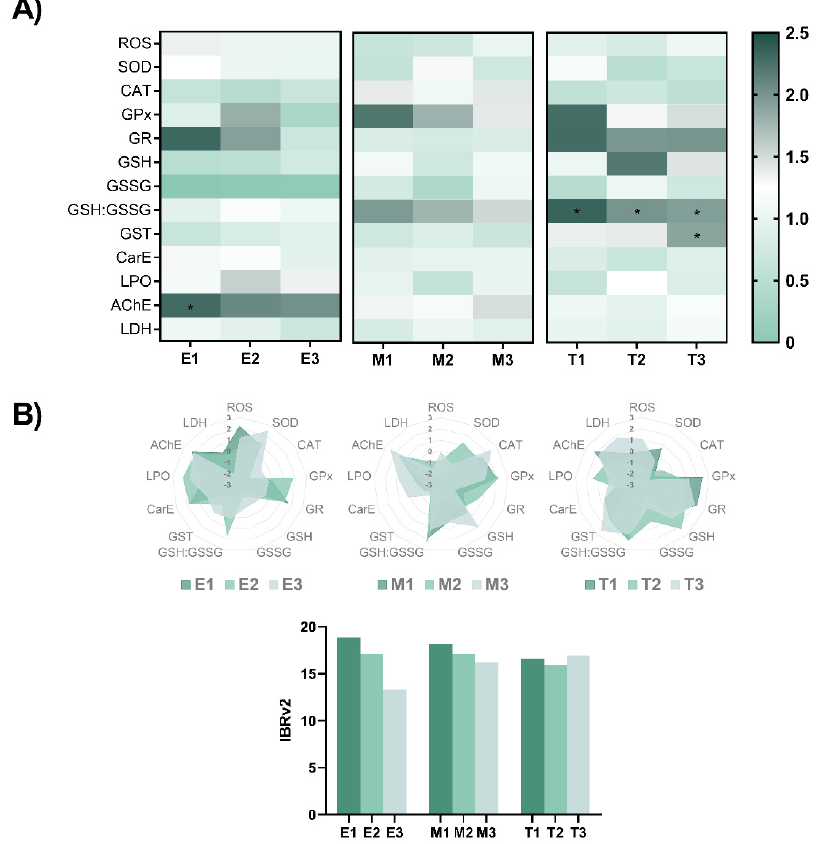
Figure 3. ( A ) Heatmap of biochemical parameters measured in zebrafish eleutheroembryo at the end of the exposure to the different phyto-fungicide. Data from at least five independent samples ( n = 100 individuals per replicate). The data used for the evaluation of the biochemical parameters were normalised to the control group value. Parametric data is expressed as mean ± SD and statis- test. The * indicate significant differences relative to the control group ( p < 0.05). ( B ) Star plots of A values obtained and IBRv2 value for biomarker responses of zebrafish embryos exposed for 96-h to the different plant-based fungicides.